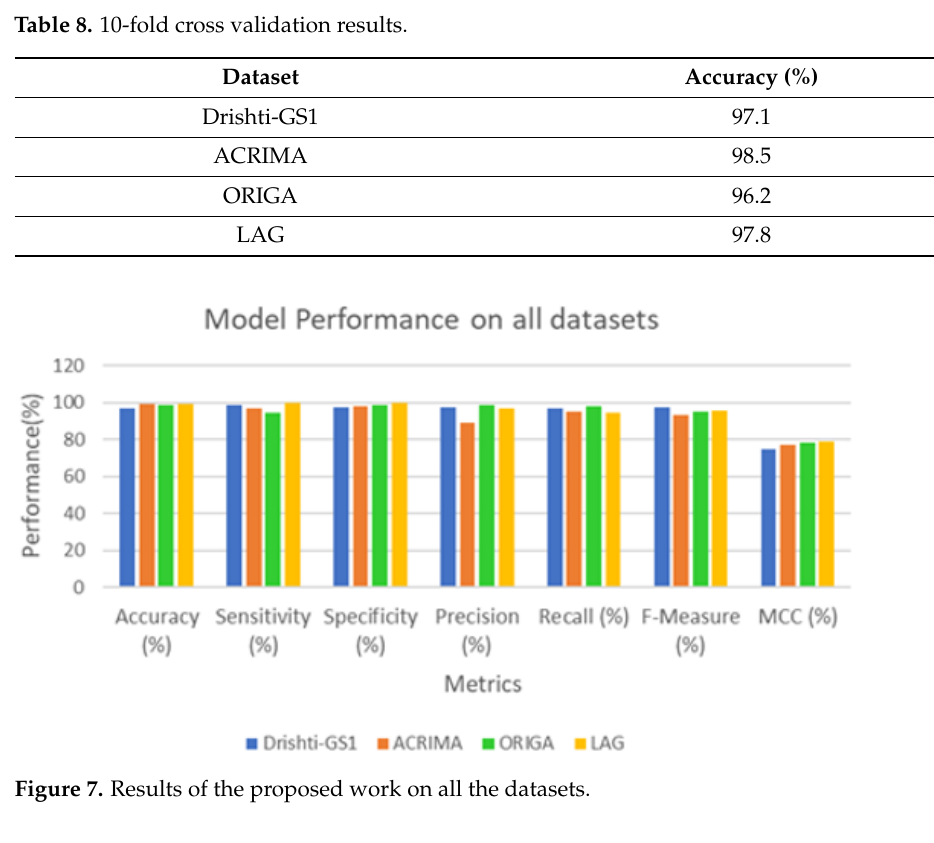
Table 8. 10-fold cross validation results.